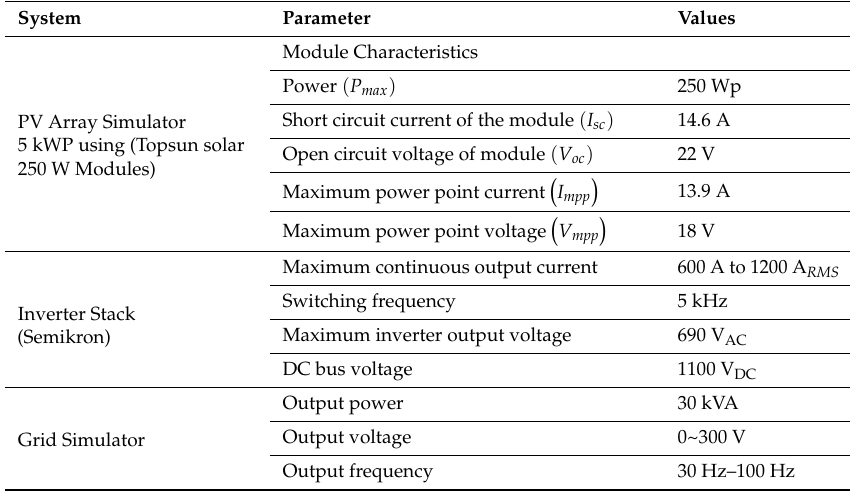
Table 2. Hardware description for a 5 kW solar photovoltaic system.